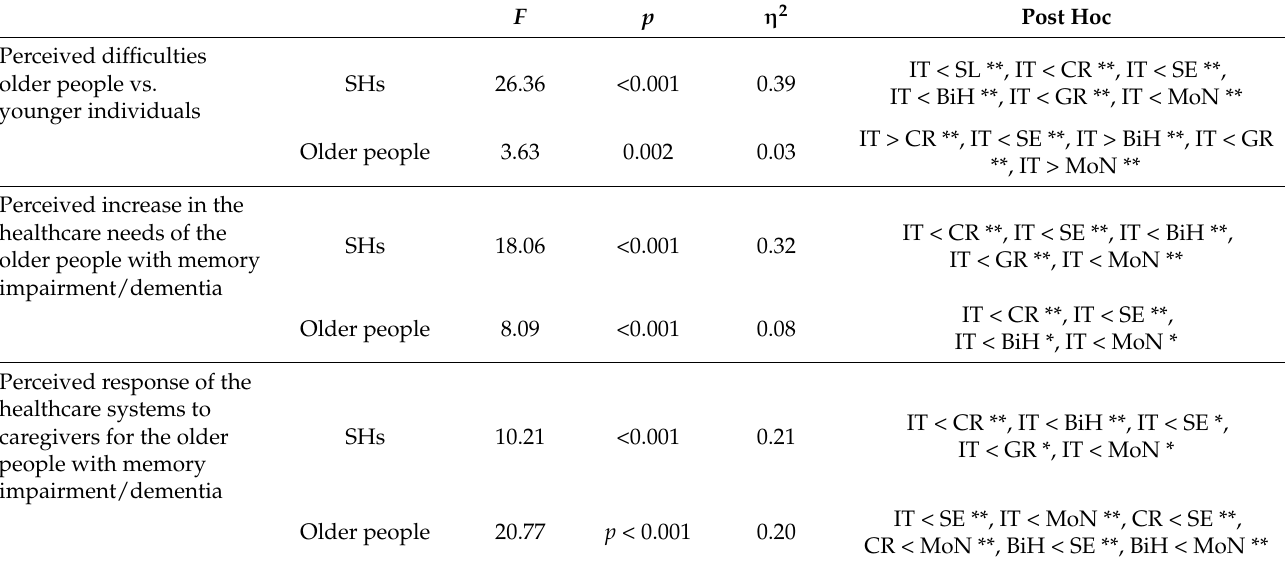
Table 3. Descriptive statistics of perceived response of the healthcare system during the COVID-19 pandemic to caregivers and country of residence. F p η 2 Post